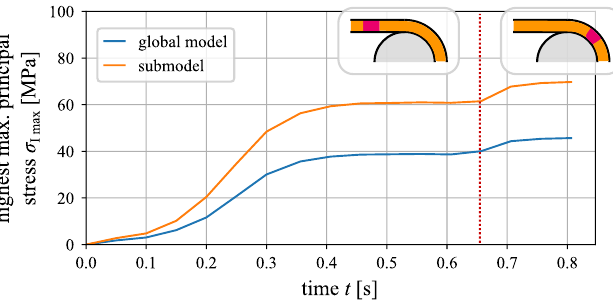
Figure 12. Time series of highest maximum principal stress values evaluated in the test rig model and the submodel. At t = 0.65s, the point of highest stress runs into the bent region of the